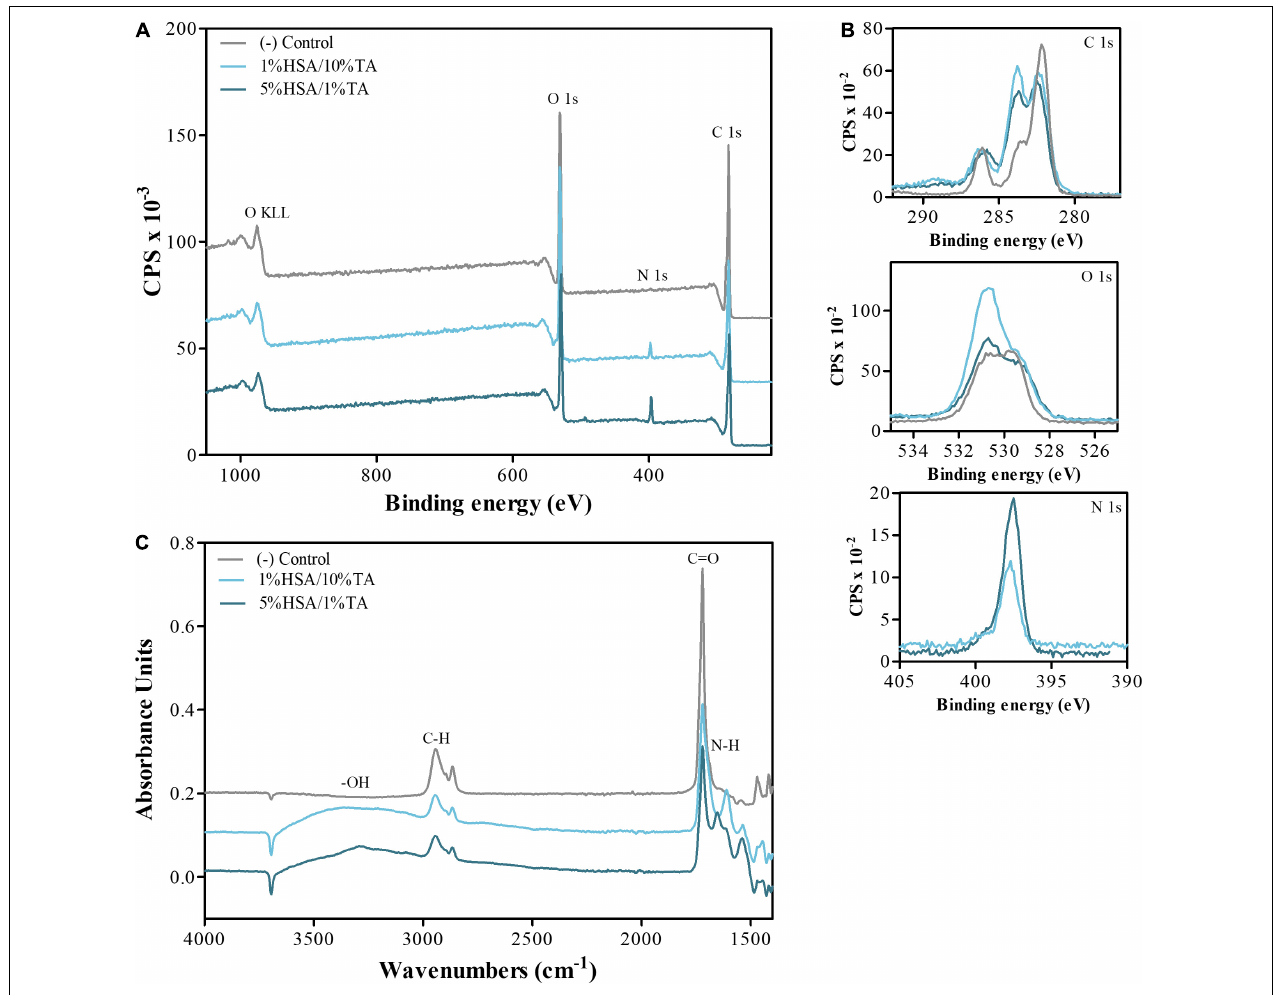
FIGURE 3 | Surface characterization of untreated and treated surfaces. (A) Wide and (B) high resolution O 1s, C 1s, and N 1s, XPS scan spectra (C) FTIR spectra evidencing the presence of hydroxyl and amide groups on the surface of treated scaffolds, demonstrating successful immobilization of HSA and TA on the surface.